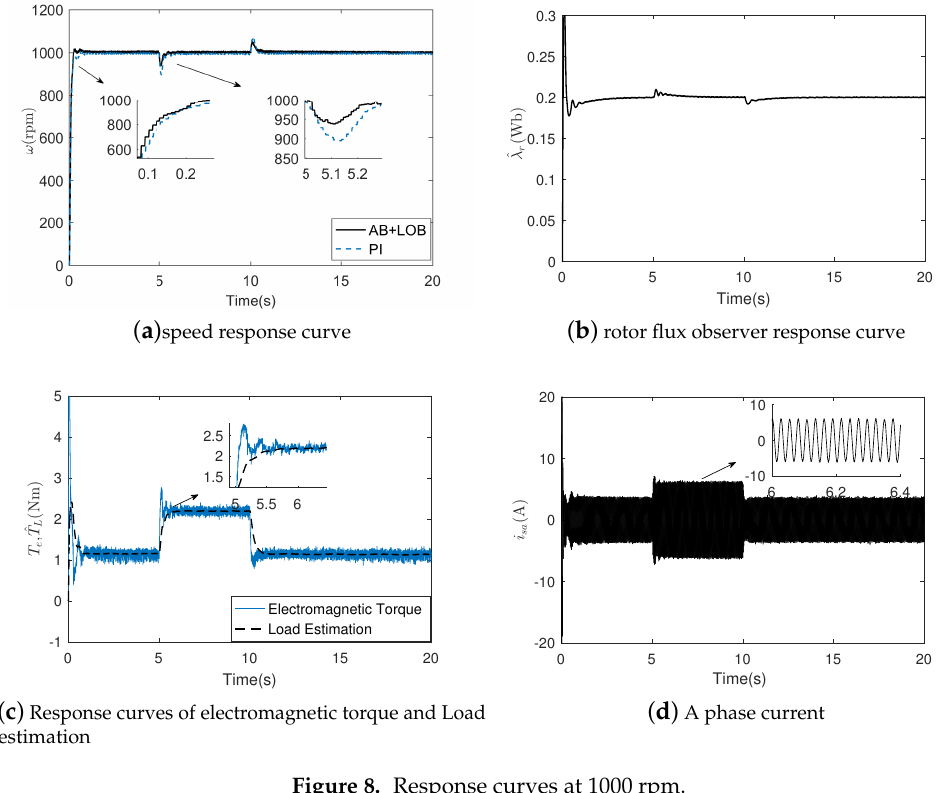
Figure 8. Response curves at 1000 rpm.